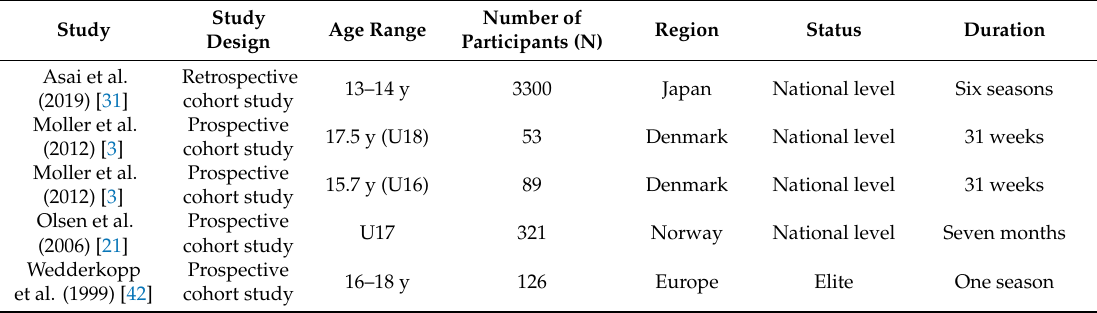
Table 4. Group and intervention characteristics in youth female handball